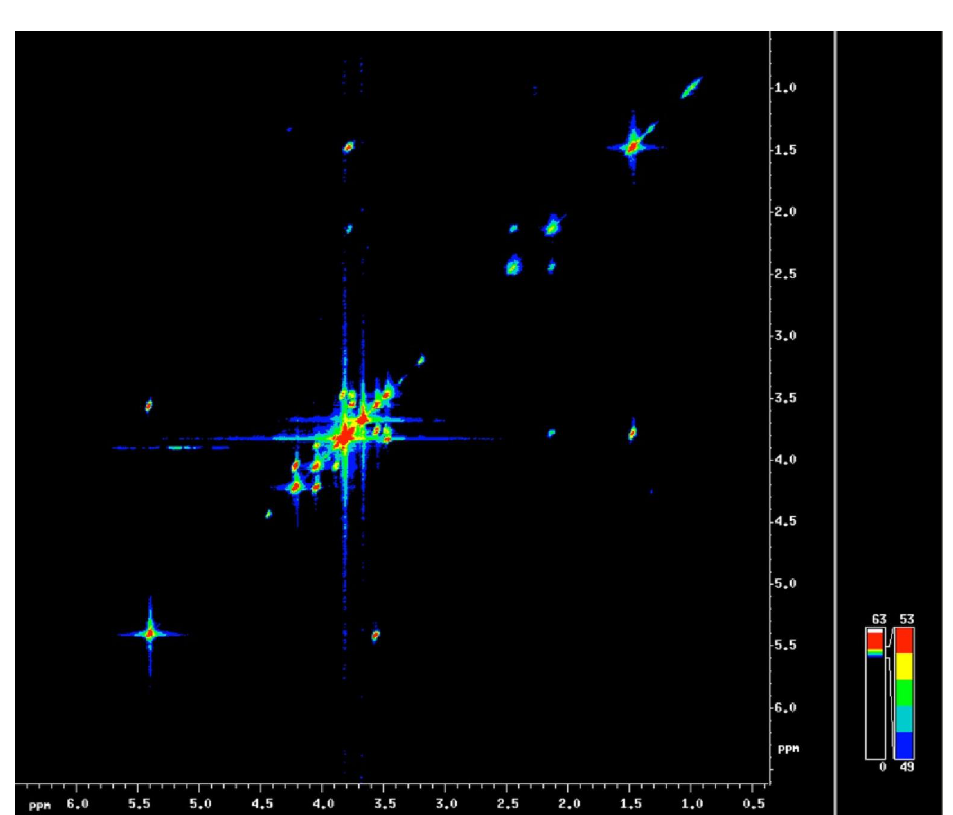
Figure 5. L-COSY spectrum of the endosperm of a pea mutant [17] seed.